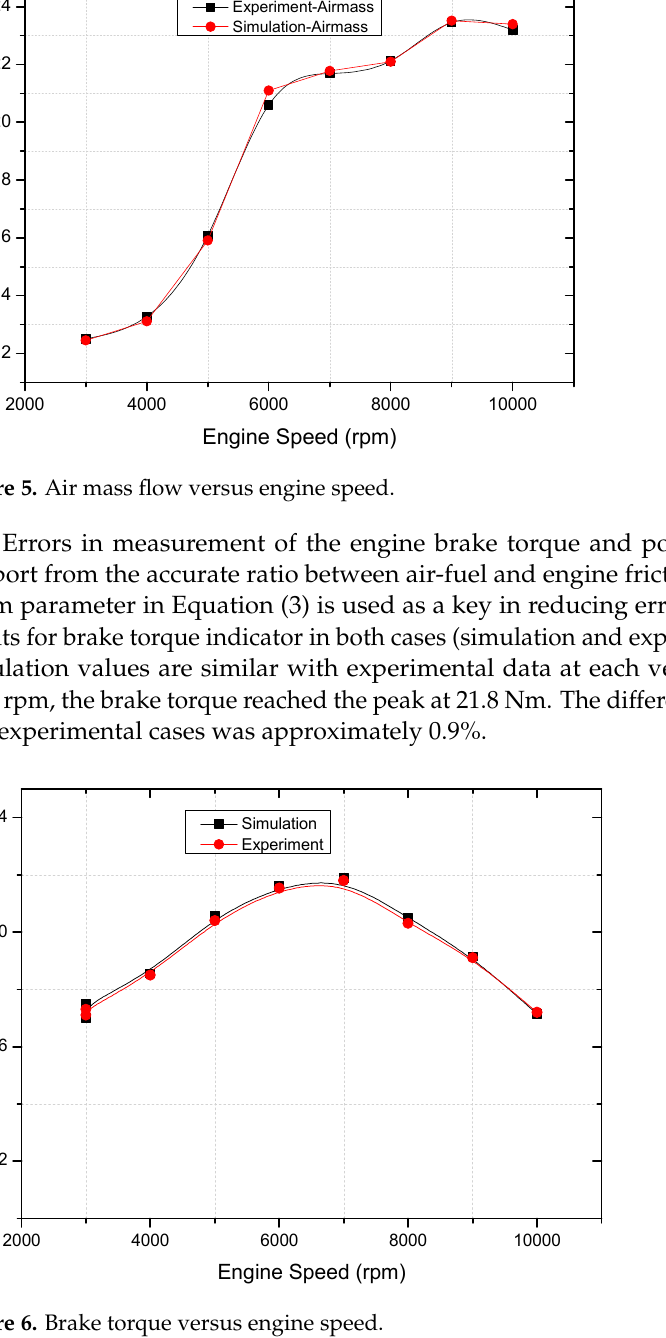
Figure 6. Brake torque versus engine speed.